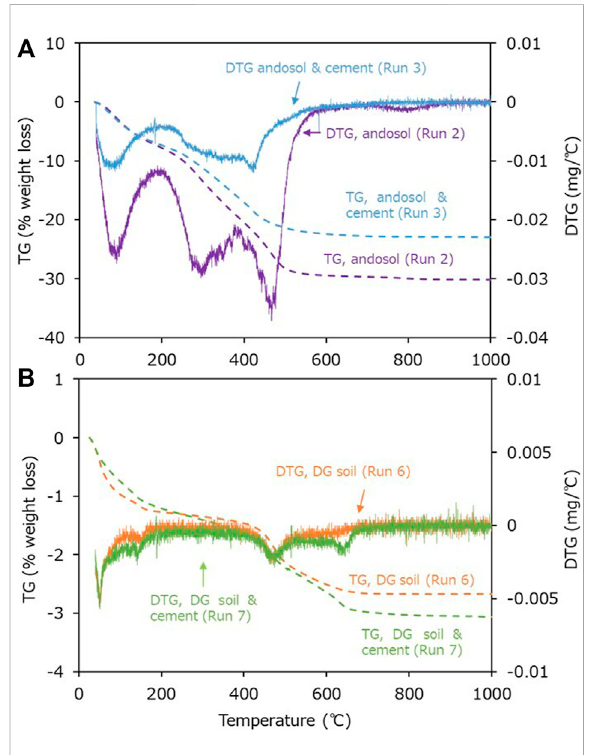
FIGURE 8 Thermogravimetry (TG) curves for the solid samples in the experiments using (A) andosol without and with Portland cement (Runs 2 and 3) and (B) decomposed granite (DG) soil without and with the cement (Runs 6 and 7).